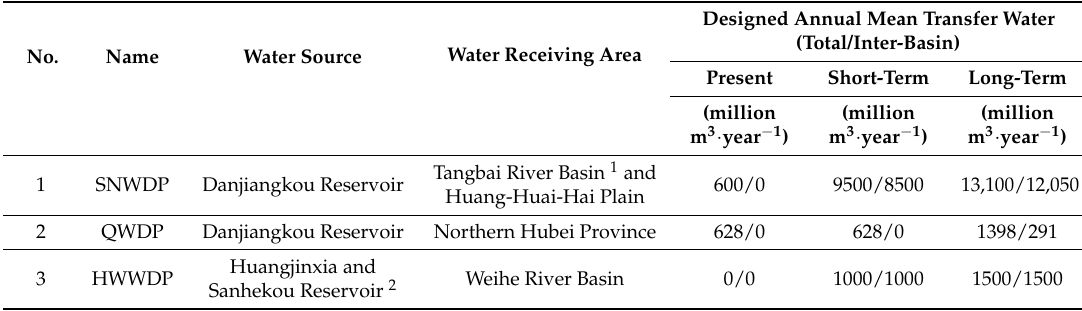
Table 1. Information of water diversion projects located in the Hanjiang River